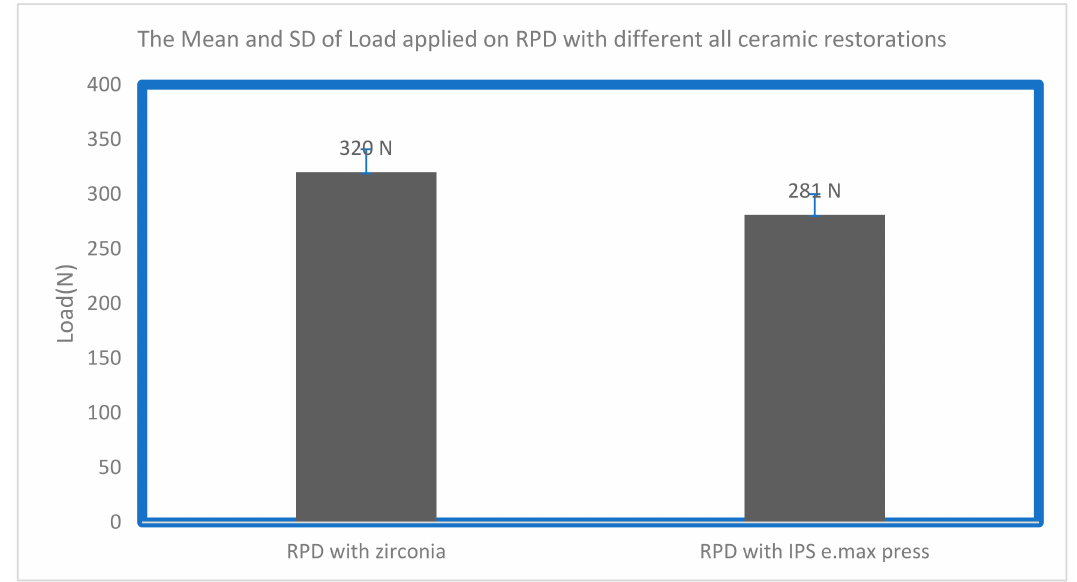
Figure 5. The mean and standard deviation of fracture strength of RPD (Co-Cr alloy) used with all-ceramic crowns (IPS e.max Press and zirconia materials).